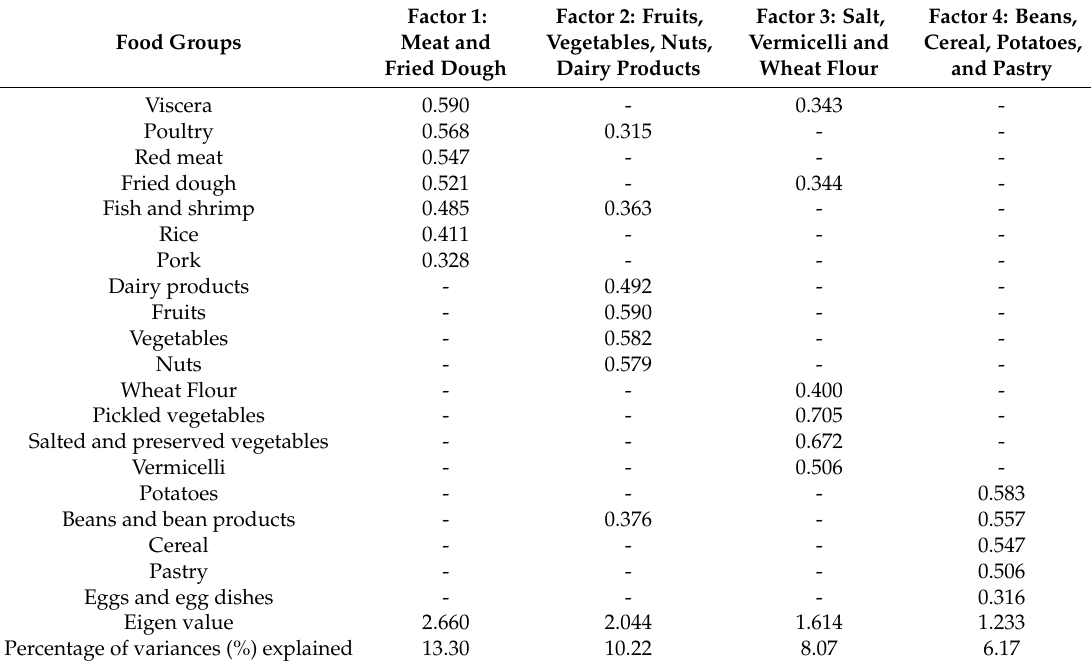
Table 4. Factors and factor loadings derived from FFQ among Chinese coal women *.